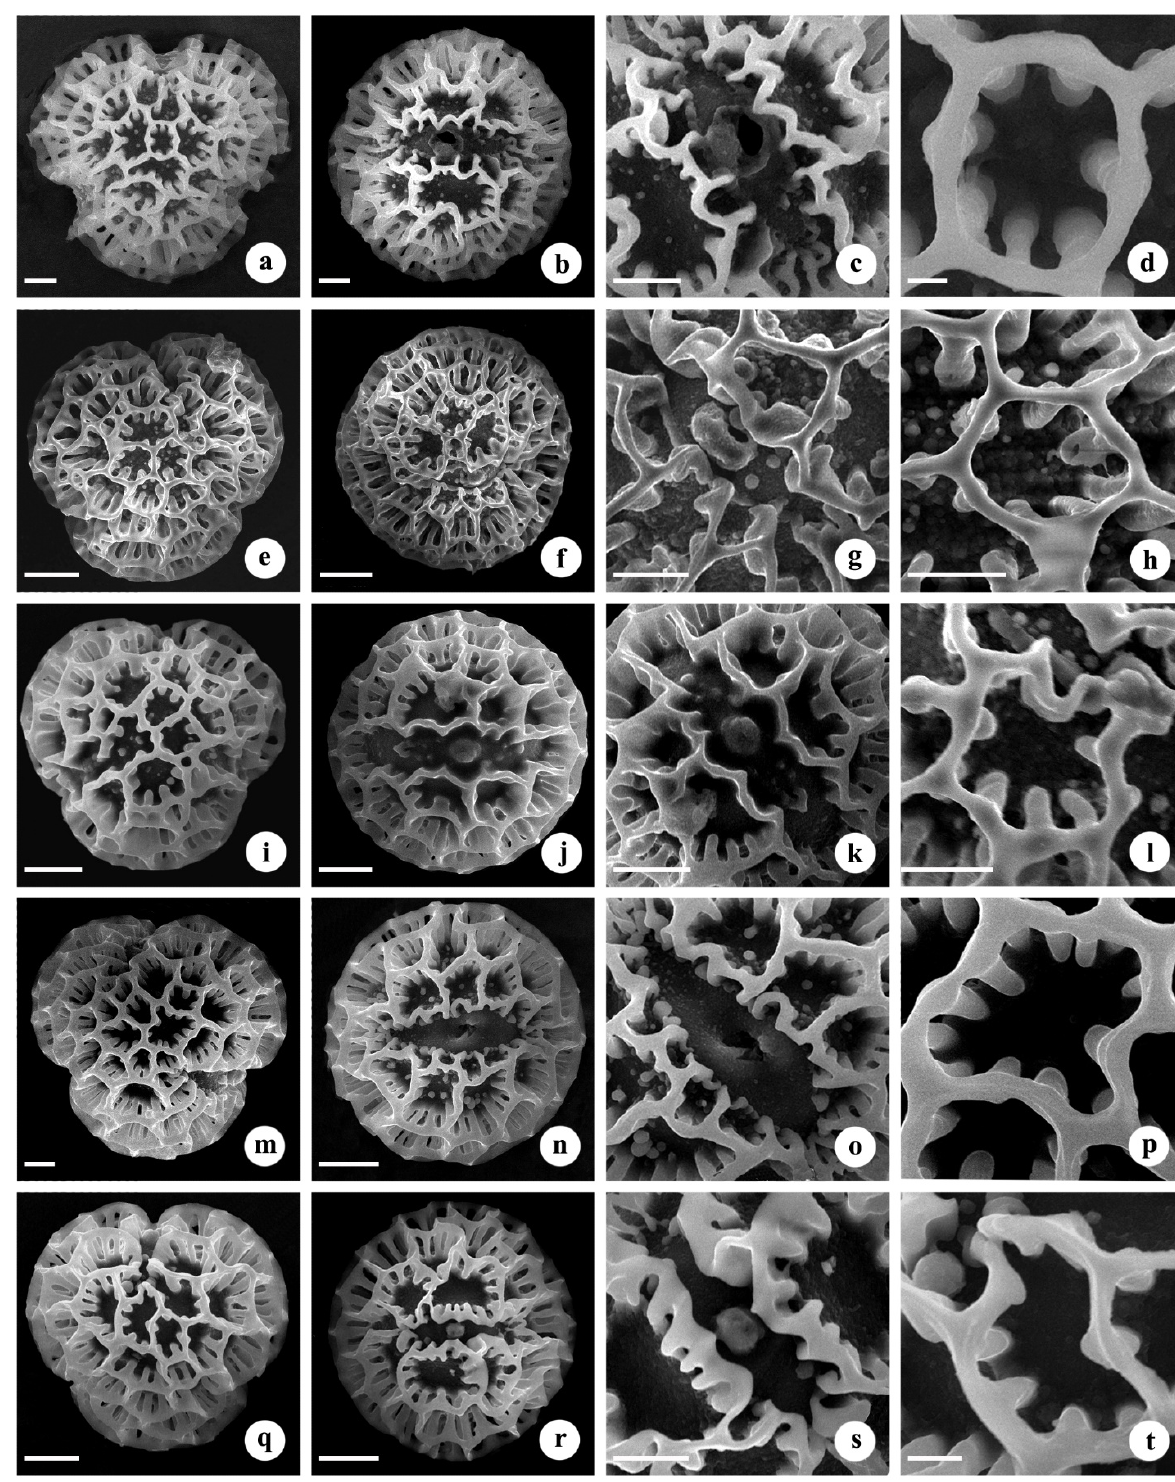
Figure 4. Scanning electron photomicrographs (polar view, equatorial view, enlarged view of aperture, enlarged view of tectum, respectively) of Barleria cristata morphotypes. ( a – d ) B. cristata cultivated form 1); ( e – h ) B. cristata (cultivated form 2); ( i – l ) B. cristata (cultivated form 3); ( m – p ) B. cristata (Nandi Hills); ( q – t ) B. cristata (Uttarakhand). Scale bars ( e , f , i , j , n , q , r ) = 20 µm; ( a – c , g , h , k – m , o , s ) = 10 µm; ( p , t ) = 5 µm; ( d ) = 2 µm.